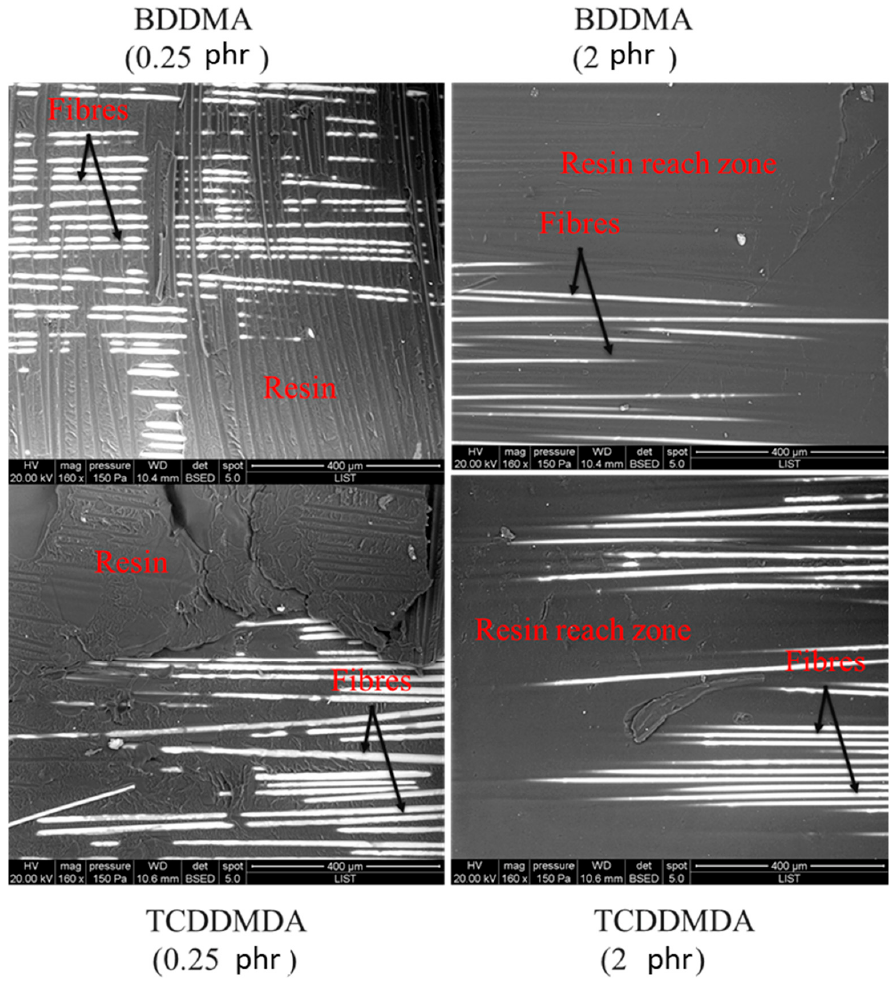
Figure 9. SEM images at the magnification of 160 times, showing the fracture surfaces of the welded composites plates with Elium ® matrix containing 0.25 phr and 2 phr of each of the multifunctional methacrylate monomers, corresponding to the highest and lowest shear strengths.